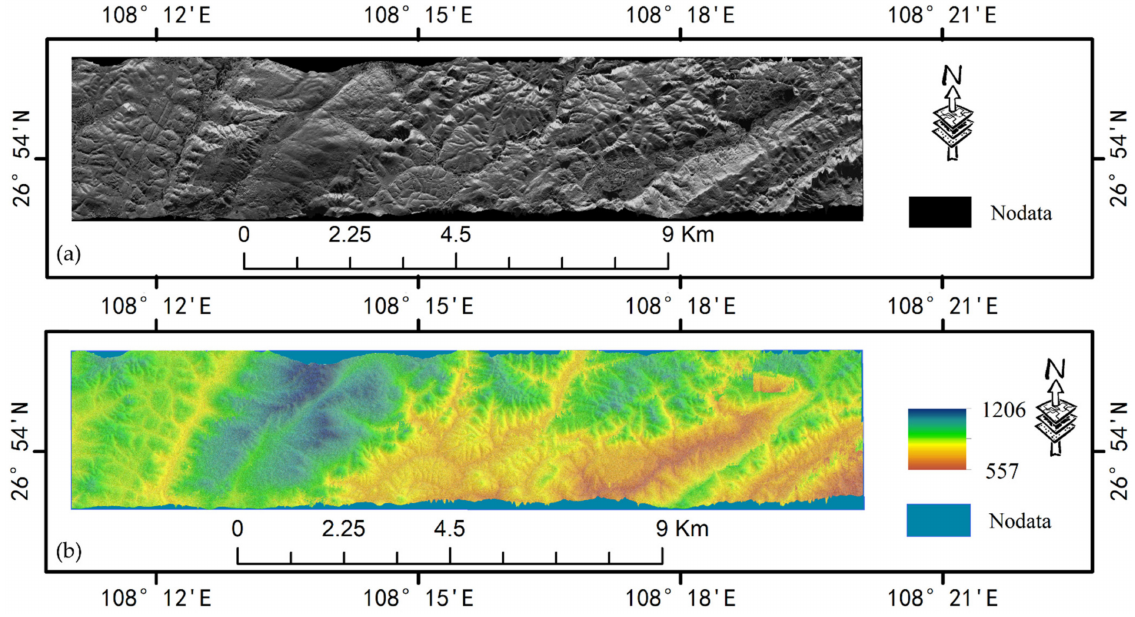
Figure 13. The obtained DOM ( a ) and DSM ( b ) of the Shibing experimental